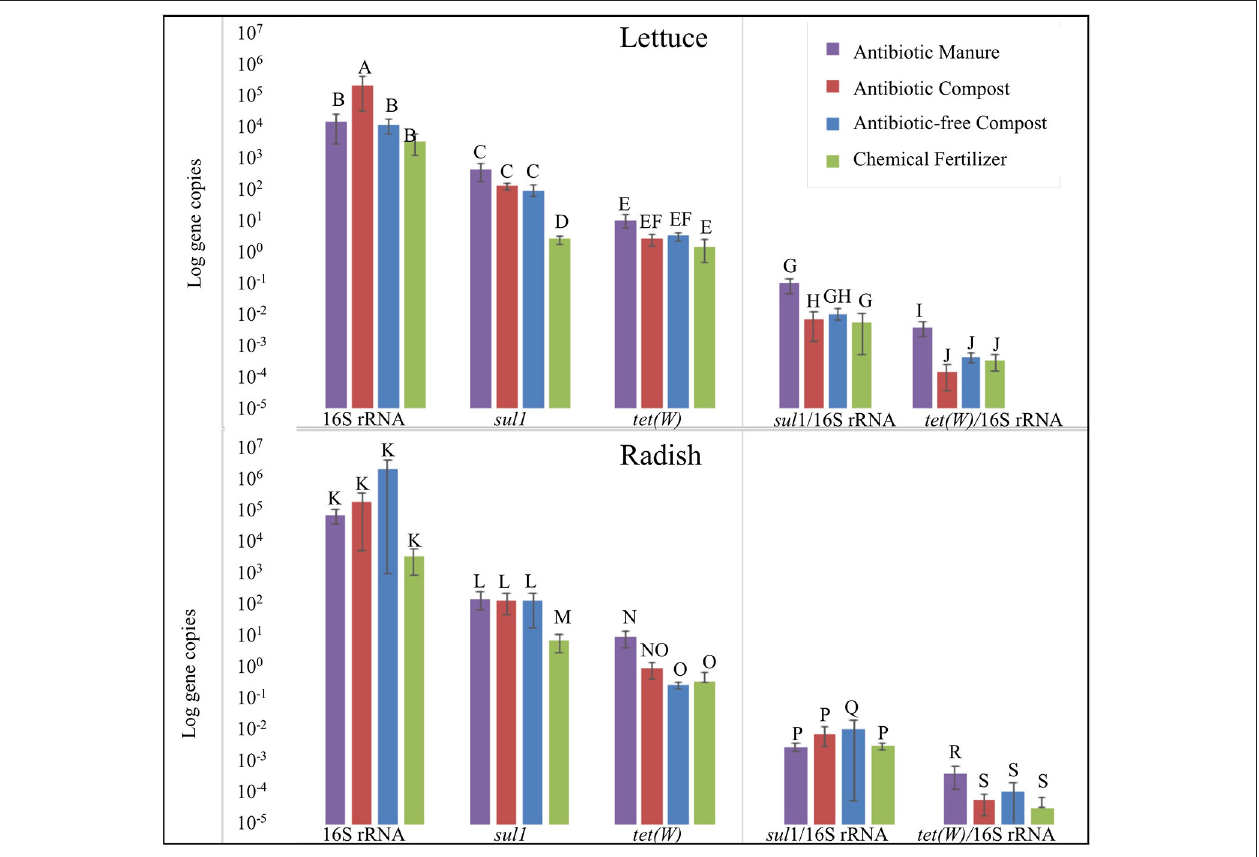
FIGURE 5 | Effect of soil amendment on gene copy numbers recovered from lettuce (top) and radish (bottom) surfaces measured by qPCR. Wilcoxon analysis with Steel-Dwass adjustment were used to determine significance ( p < 0.05). Error bars represent 1 standard error from the mean. Letters denote significant differences between soil amendment type ( n = 3, except n = 2 for Radish Antibiotic compost due to lost sample).